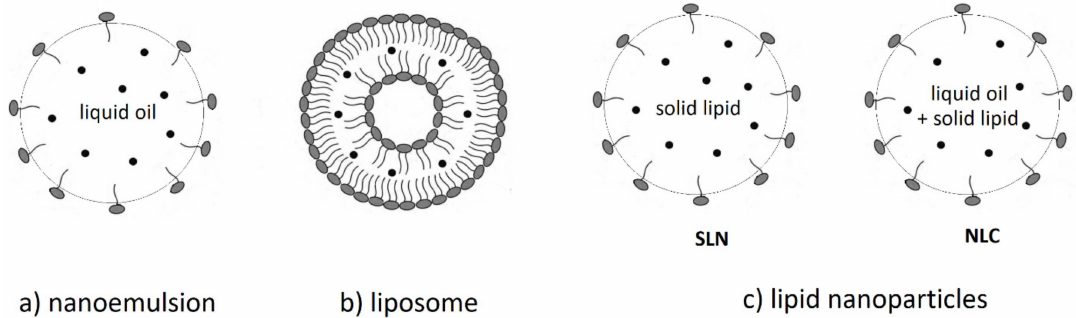
Figure 8. Lipid-based nanocarriers: ( a ) O / W nanoemulsion: Liquid oil in continuous aqueous phase stabilized by surfactant (amphiphilic molecule, in gray). Carotenoid molecules are shown as black dots. ( b ) Liposome: concentric phospholipid bilayer with a hydrophilic center. Carotenoids shown as black dots are imbedded in the hydrophobic area of the bilayer. ( c ) Lipid nanoparticles: Solid lipid nanoparticles (SLNs) are constituted only by solid lipids, whereas nanostructured lipid carriers (NLCs) are a mixture of mainly solid with liquid lipids. Carotenoid molecules are shown as black